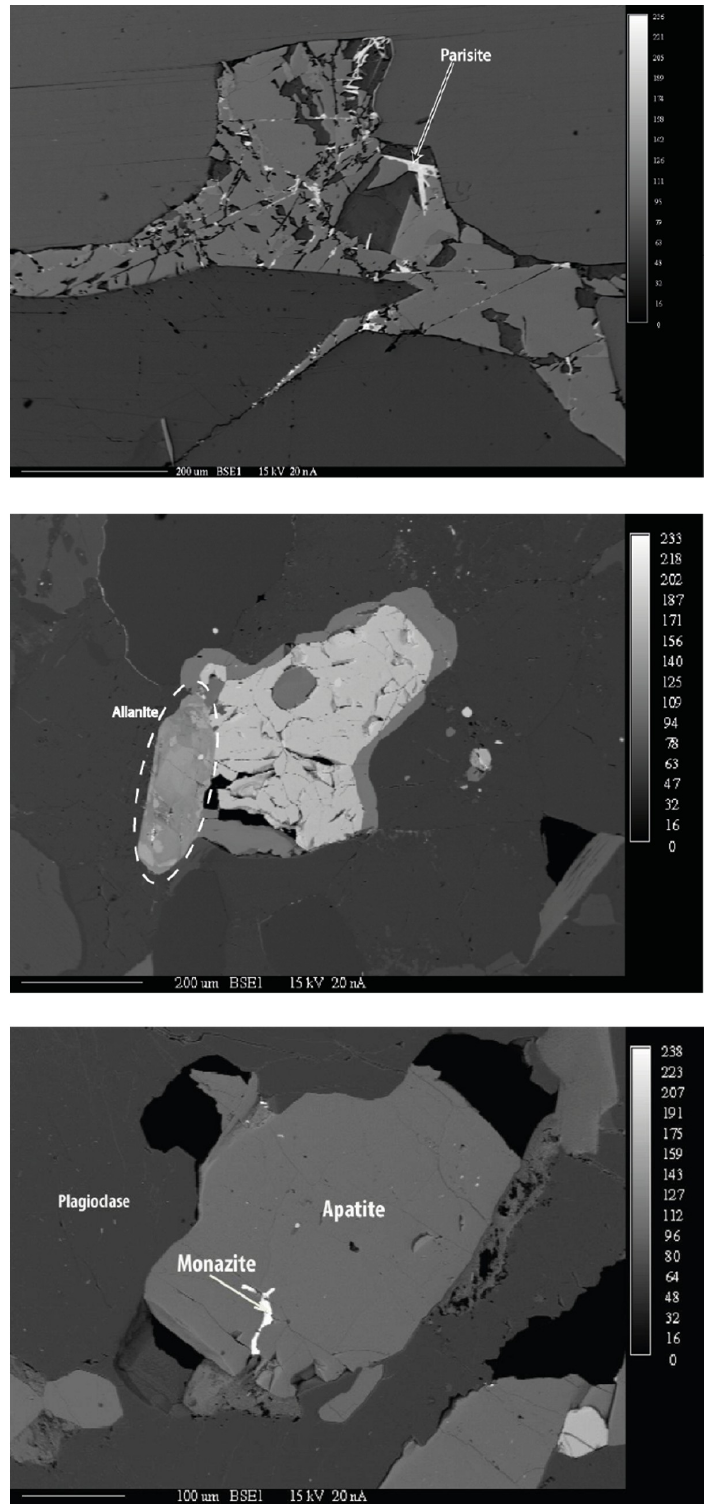
Figure 5. Backscattered electron photography of REE-bearing phases in the investigated rocks. ( a ) represents parisite as a hypidiomorphic crystal which is about 50 µm in diameter near a carbonate mineral, ( b ) represents the allanite as a large (500 µm) idiomorphic crystal either dissiminated in the matrix or near any other mineral, ( c ) represents the monazite which is about 100 µm in diameter and always as an inclusion or on the side of the apatite.